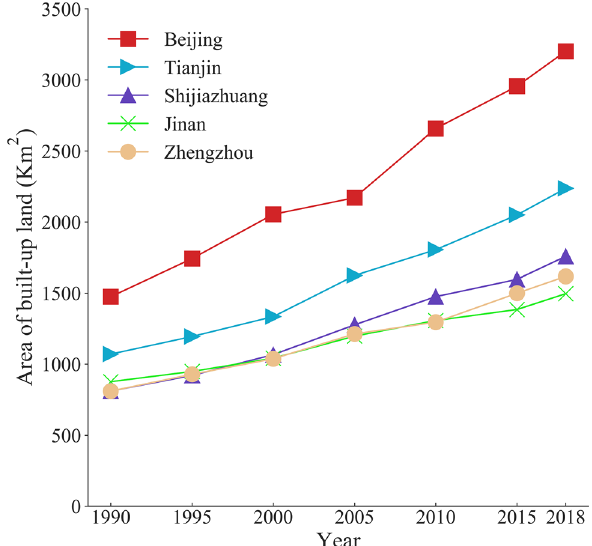
Figure 5. Area of built-up land in each city during 1990–2018.